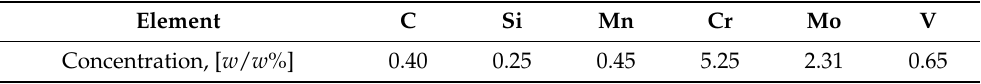
Table 1. Chemical composition of the used steel in weight percentage ( w / w %).